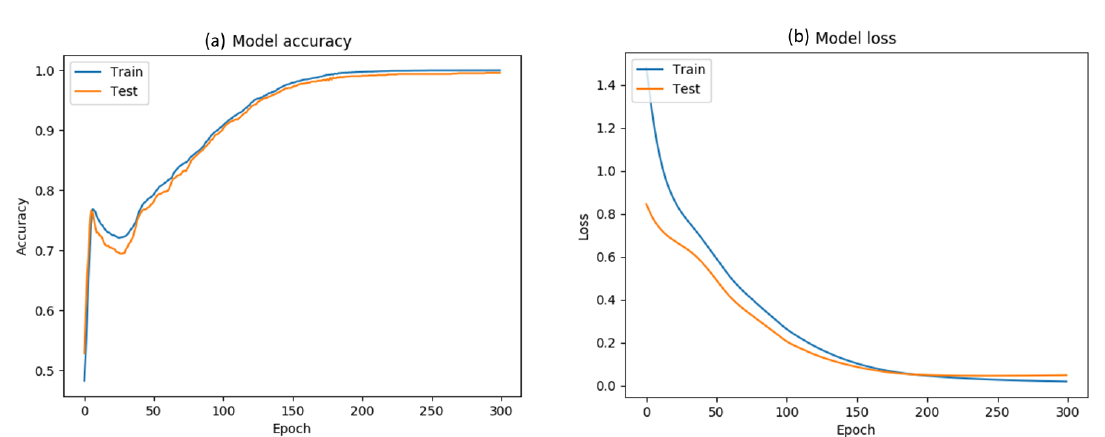
Figure 9. Model performance evaluation. ( a ) Train/test accuracy and ( b ) train/test loss